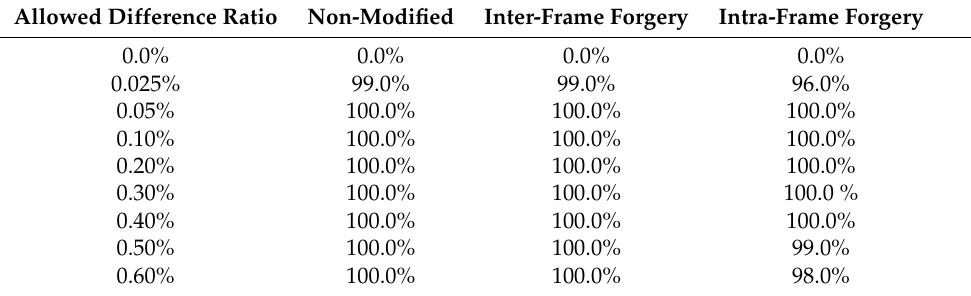
Table 2. Comparison accuracy between original videos and retouched